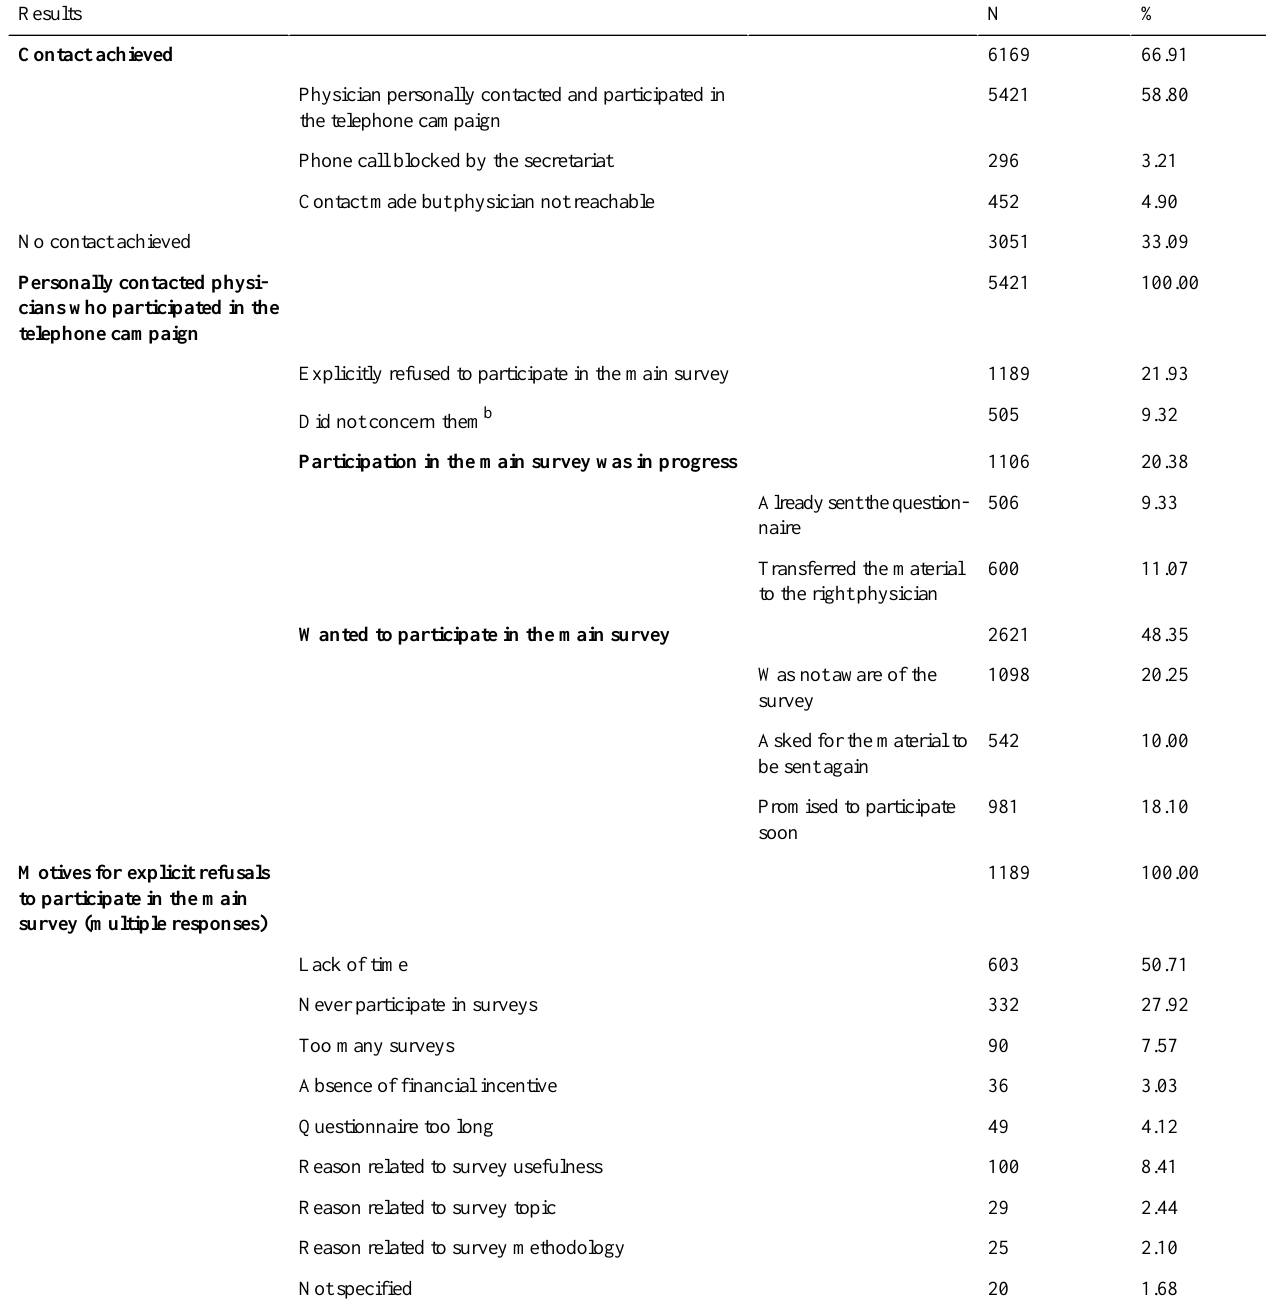
Table 3. Results of the telephone campaign and motives for nonresponse.